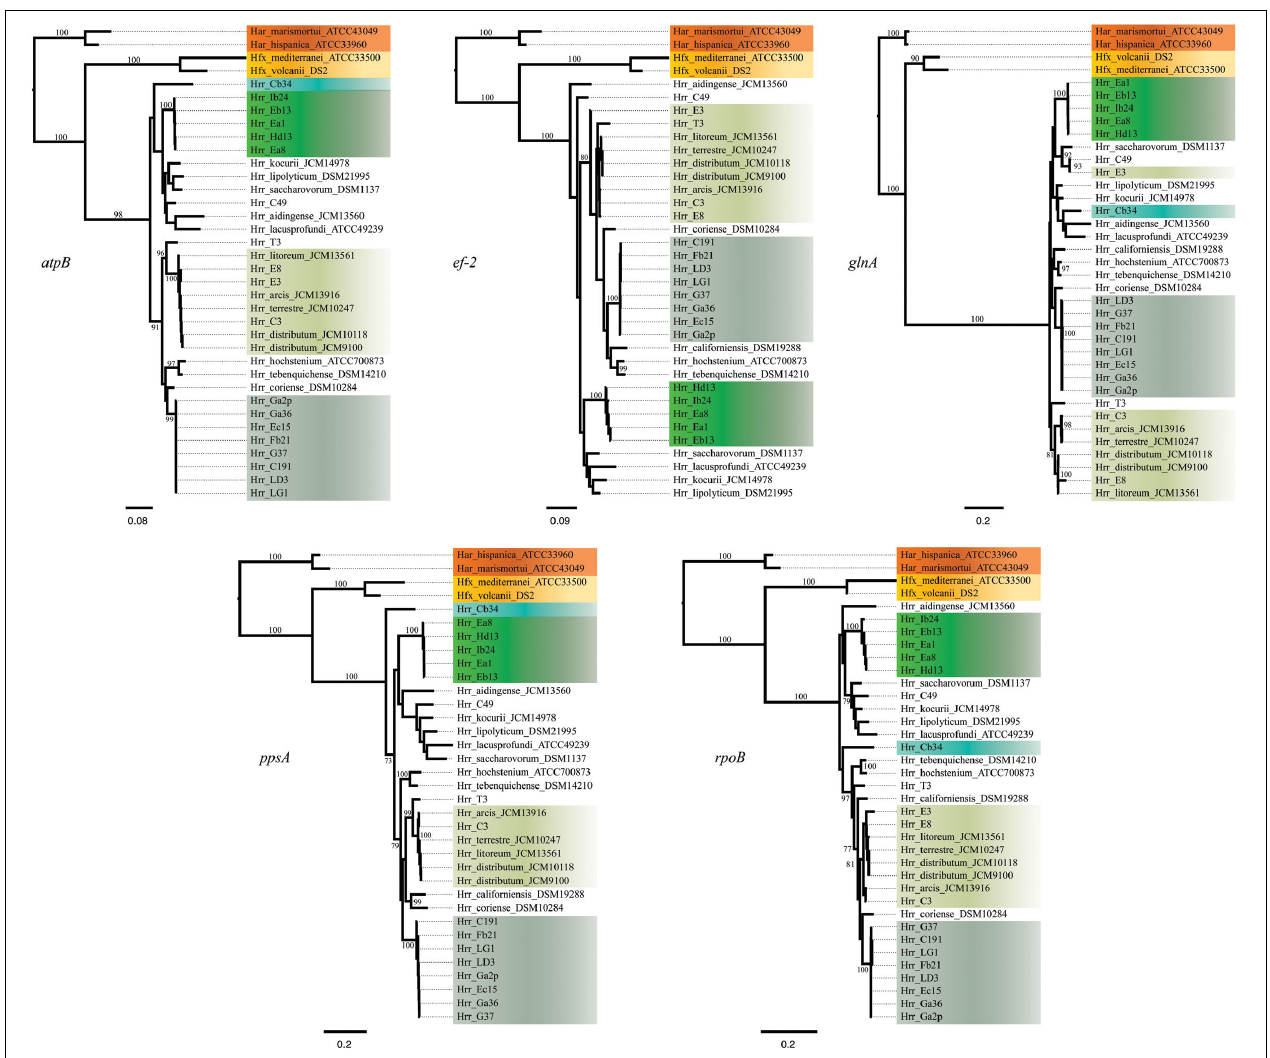
FIGURE 1 | Maximum-likelihood gene trees made from the DNA sequences of atpB, ef-2 , glnA , ppsA , and rpoB . Support values on branches are bootstrap replicates. Bootstrap values below 70 are not